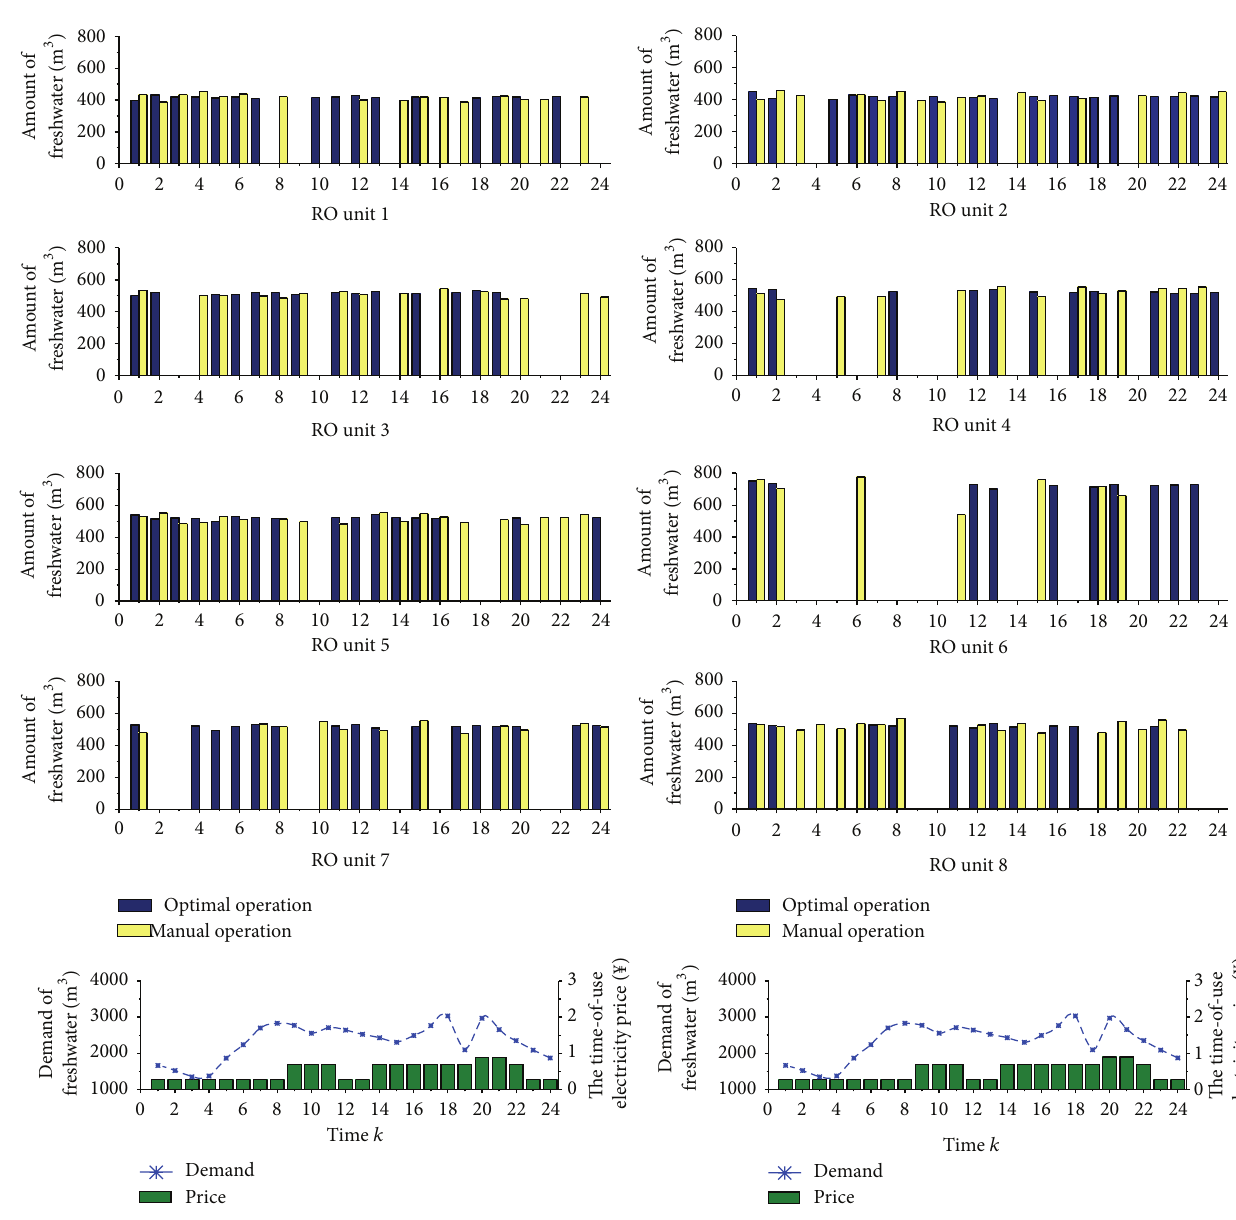
Figure 5: The comparison of capacity of each RO